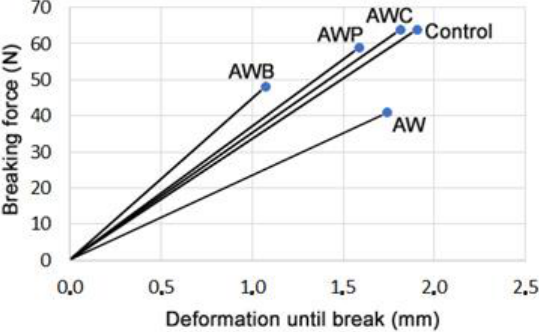
Figure 2. Breaking force and deformation until break of the cookies elaborated with the different formulations. Control — wheat flour (100%) and butter (100%); AWP — maize flour (50%), almond flour (33%), walnut flour (14%), poppy flour (3%), walnut oil (70%) and poppy oil (30%); AW — maize flour (60%), almond flour (28%), walnut flour (12%) and walnut oil (100%); AWC — maize flour (60%), almond flour (23%), walnut flour (12%), chia flour (5%), almond oil (50%) and walnut oil (50%); AWB — maize flour (82%), walnut flour (12%), almond flour (6%), butter (50%) and walnut oil (50%).